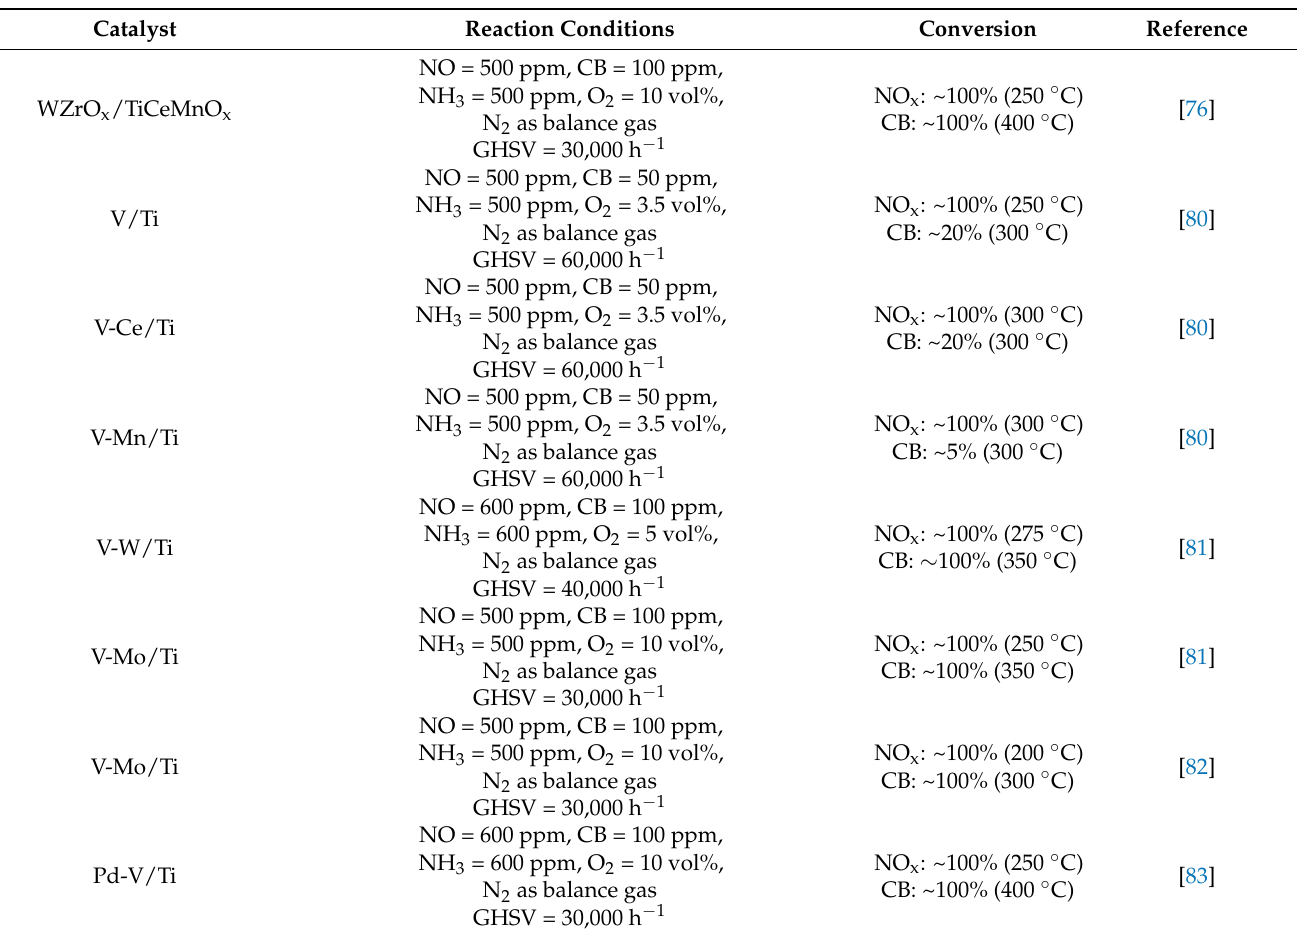
Table 3. Loaded transition metal oxide catalysts and their synergistic removal efficiency of NO and